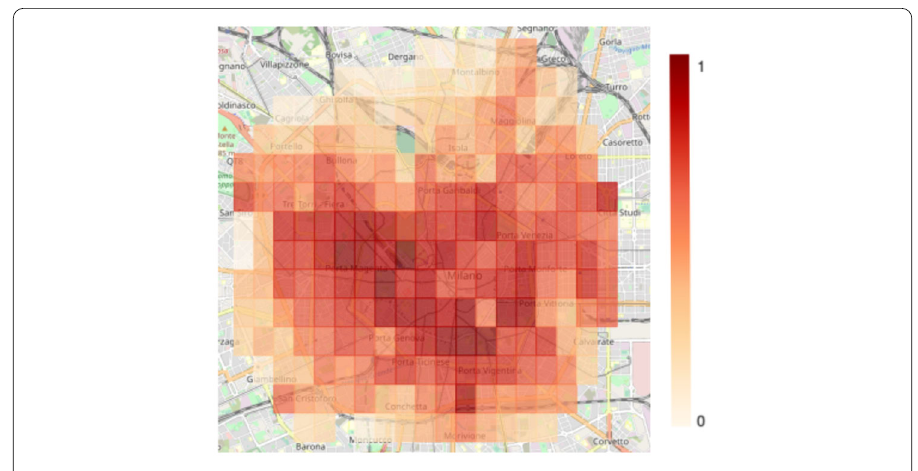
Figure 3 Distribution of the proportion of graduates in the city